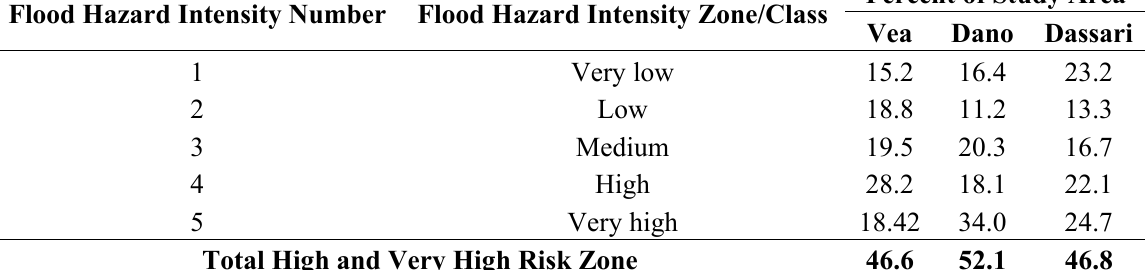
Table 4 . Proportions of areas under various flood intensity